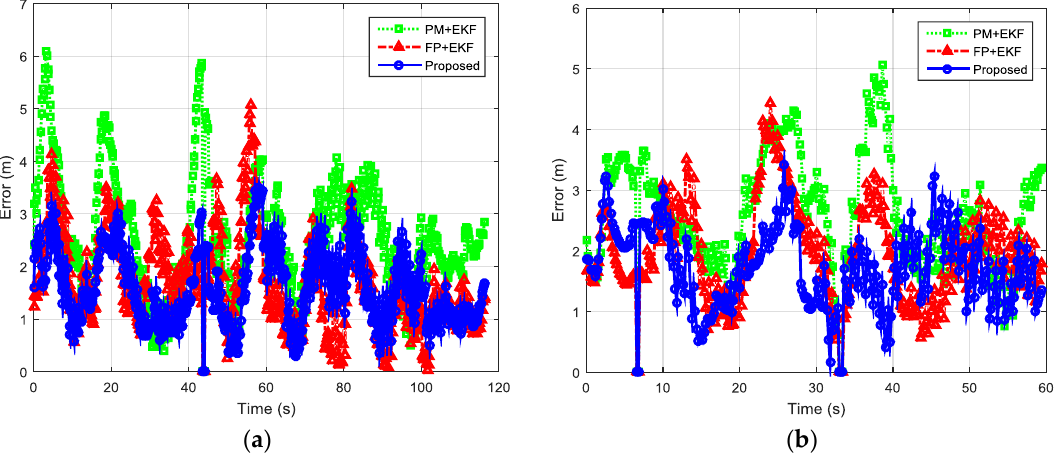
Figure 13. Localization errors of two indoor trajectories with densely distributed BLE beacons using the proposed method, PM + EKF, and FP + EKF: ( a ) Trajectory I; and ( b ) Trajectory II.